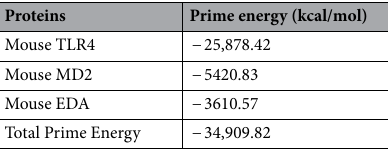
Table 3. Prime energies of the individual binding proteins along with their total prime energy in mouse.